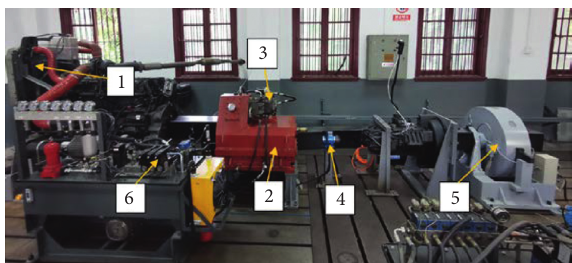
Figure 3: Test bench of HMCVT. ① Engine. ② HMCVT. ③ Pump- motor system. ④ Rotating speed-torque sensor. ⑤ Speed-up box. ⑥ Electric eddy current dynamometer. ⑦ Hydraulic control system and lubrication system of wet